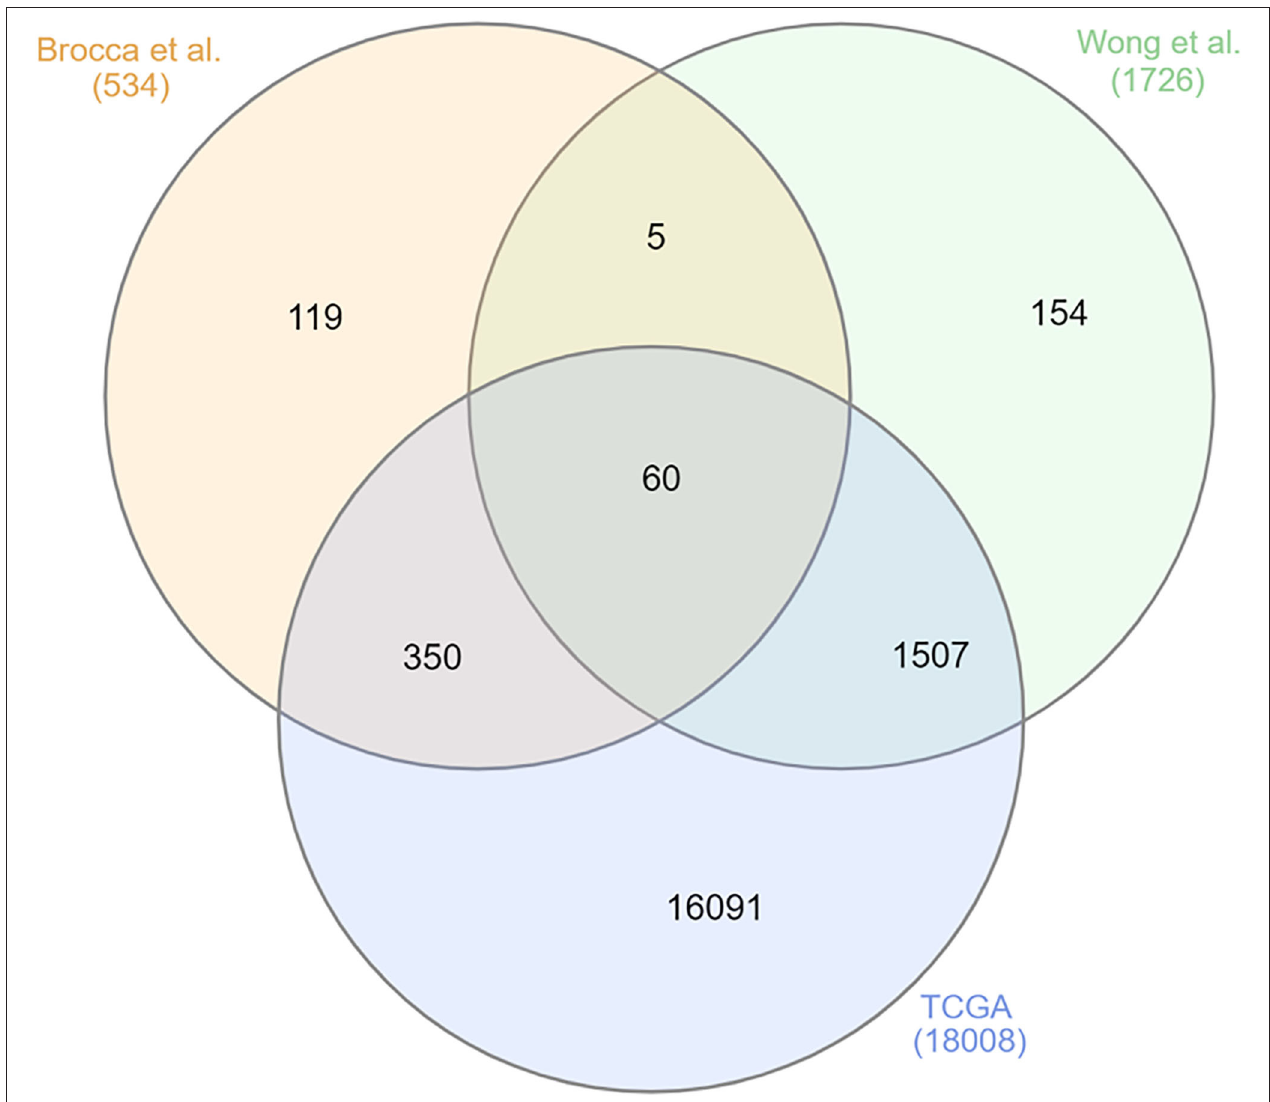
FIGURE 2 | Venn diagram demonstrating the most commonly mutated genes among the three datasets, two canine oral melanoma (8, 9) and one human melanoma dataset (The Cancer Genome Atlas—TCGA 10). Here, 60 commonly mutated genes were identified. Figure generated online